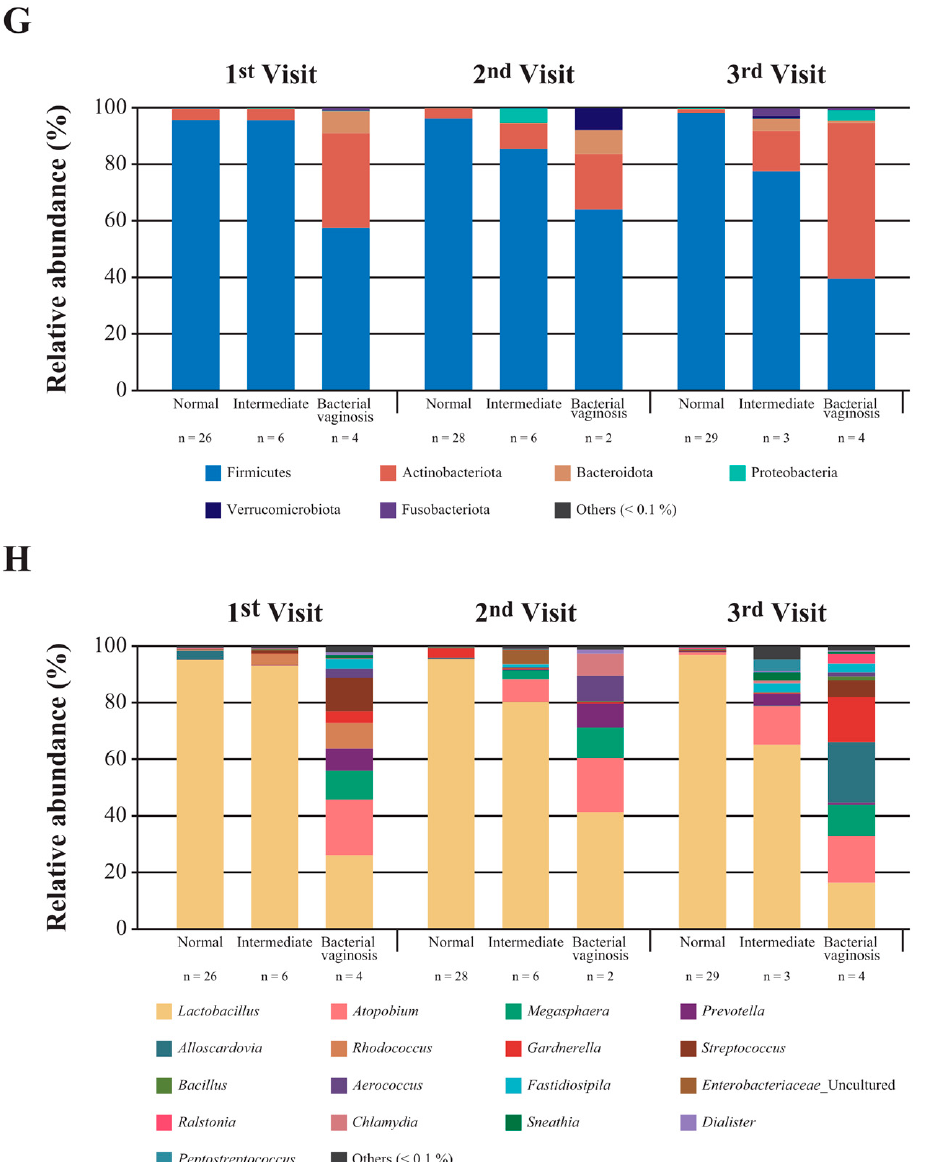
Figure 3. Alpha diversity and correlation between the Nugent score and alpha diversity, and the taxonomic composition of the vaginal microbiota between groups at different visits. Boxplot illus- trating the ( A ) observed amplicon sequence variants (ASVs), ( B ) Shannon diversity, and ( C ) Pielou’s evenness. Spearman’s correlation between the Nugent score with the ( D ) observed ASVs, ( E ) Shan- non diversity, and ( F ) Pielou’s evenness. Relative abundance by visit order at the ( G ) phylum and ( H ) genus levels. * p < 0.05, *** p < 0.001 (Wilcoxon rank-sum test).